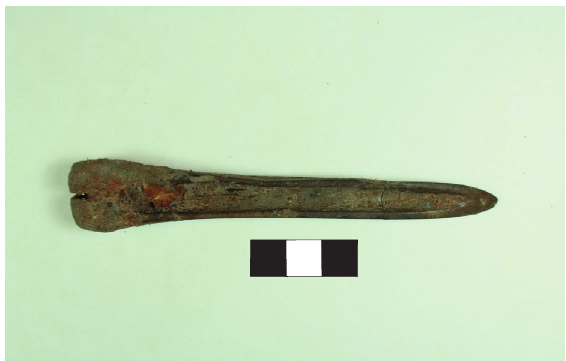
Figure 8 - Bone artifact (“spatula”) found at Lapa do Santo. Piece